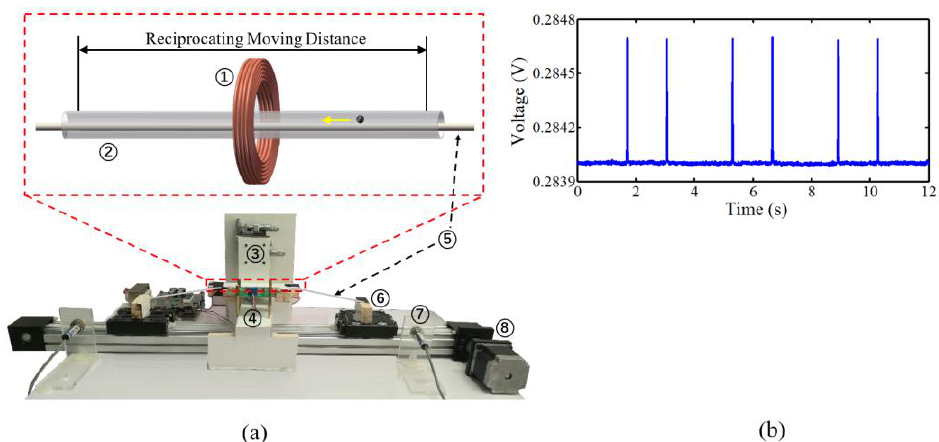
Figure 8. ( a ) The experimental setup with (1) sensing coil, (2) glass tube, (3) three-axis precision moving stage, (4) signal detection circuit, (5) nylon fiber, (6) slide stages, (7) electromagnetic limit switches, and (8) step motor. ( b ) The detection signal when an 86 μm iron particle reciprocally passes through the sensing coil.